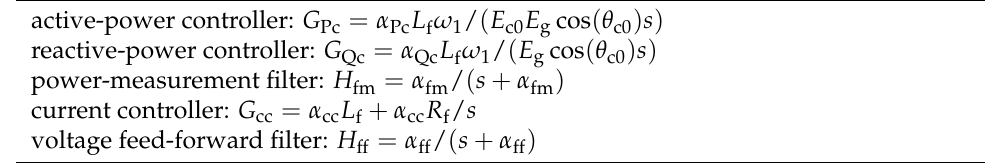
Table 1. Control parameters for the